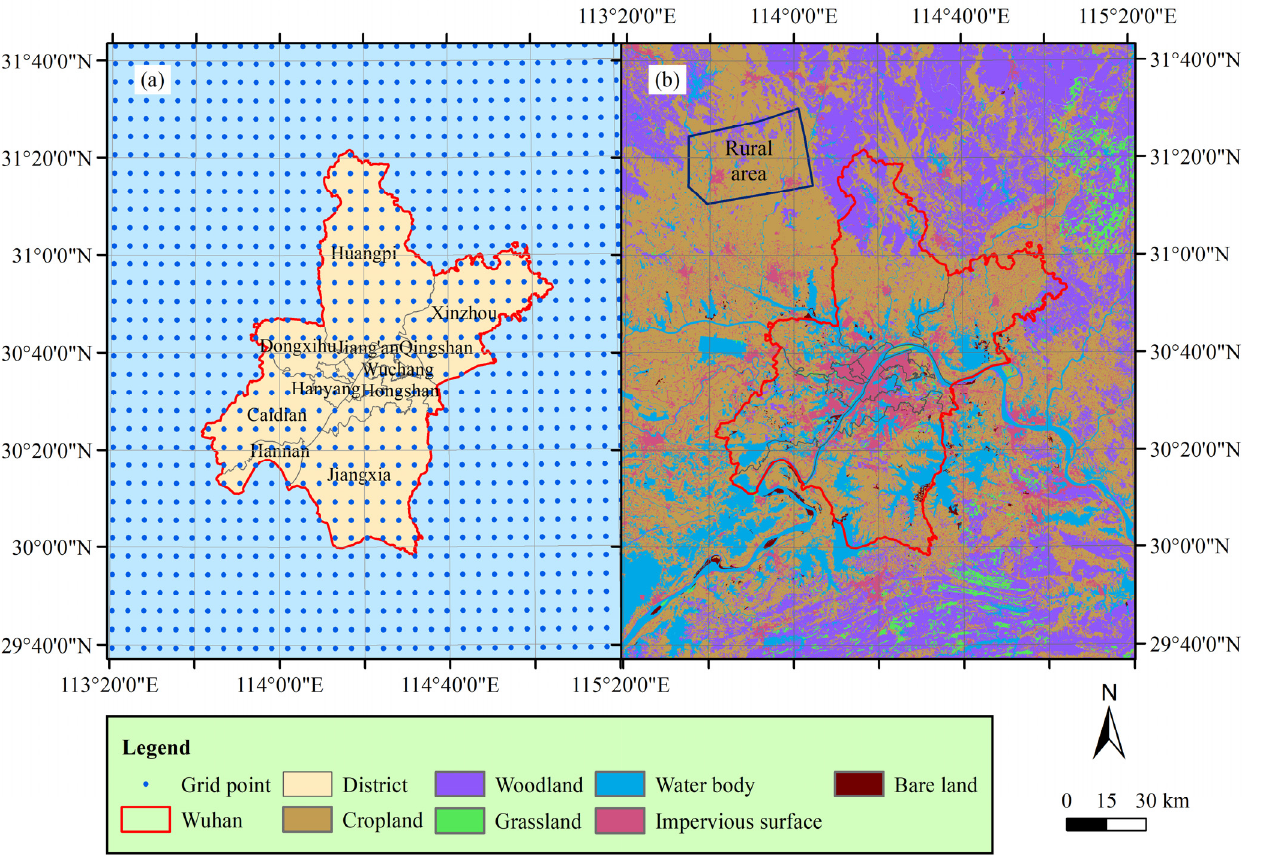
Figure 1. Study area. ( a ) Grid points of the air temperature; ( b ) Land uses.